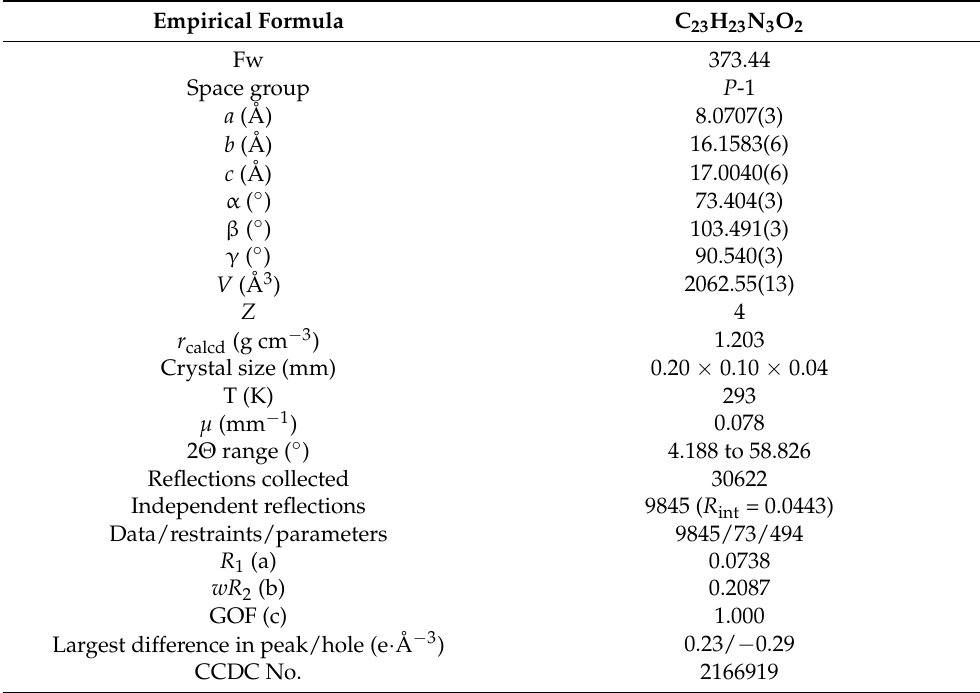
Table 1. Crystal data and details of the data collection for 4d